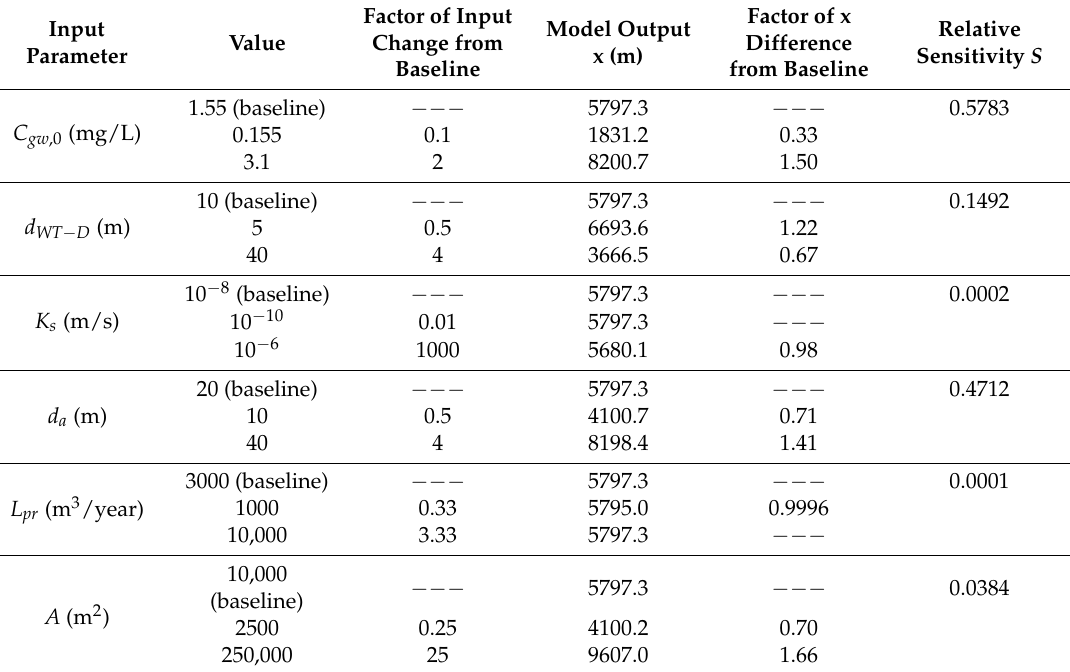
Table 7. Sensitivity analysis for the proposed